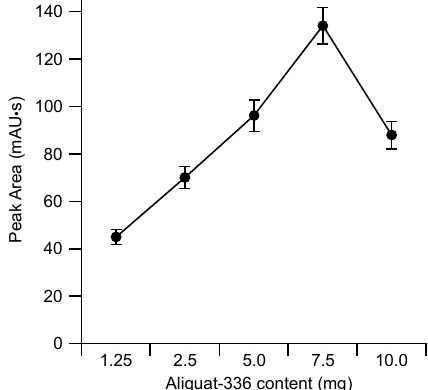
Figure 3. Effect of the content of Aliquat 336 in membranes based on 7.5 mg cellulose triacetate (CTA) and 5 mg o ‐ nitrophenyl octyl ether (NPOE) on the extraction efficiency of naproxen. Donor background: 100 μ M NaClO 4 at 2 μ L/min; acceptor phase: 100 μ M NaClO 4 in 1.5 μ L; standard: 10 μ L of 50 μ M naproxen in 100 μ M NaClO 4 , applied voltage: 150 V. Each data point represents the mean value for five measurements.